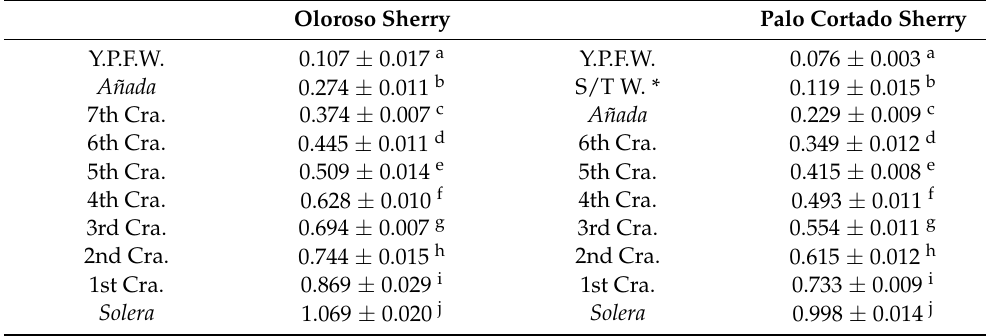
Table 9. Absorbance values at 470 nm (a.u.) in the Oloroso and Palo Cortado Sherry wines. Oloroso Sherry Palo Cortado Sherry Y.P.F.W. 0.107 ± 0.017 a Y.P.F.W.